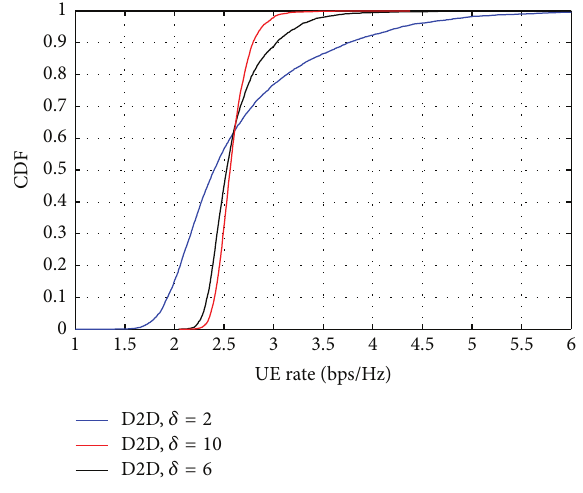
Figure 7: UE rate distribution under different 𝛿